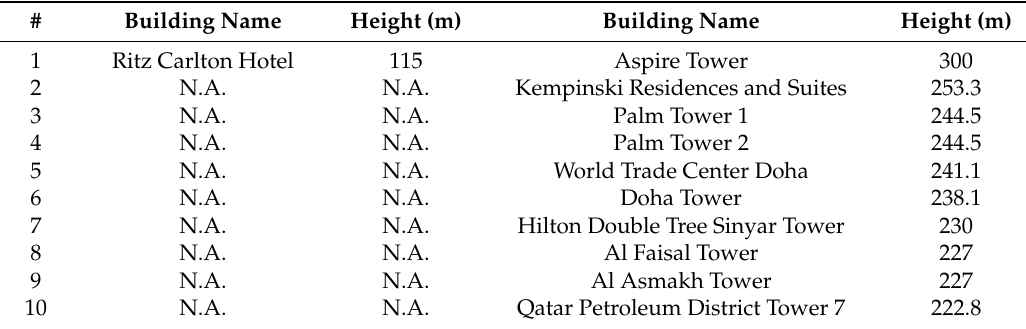
Figure 16. Doha in 2000 and 2020. Table 26. Doha’s 10 tallest skyscrapers in 2000 and 2020.